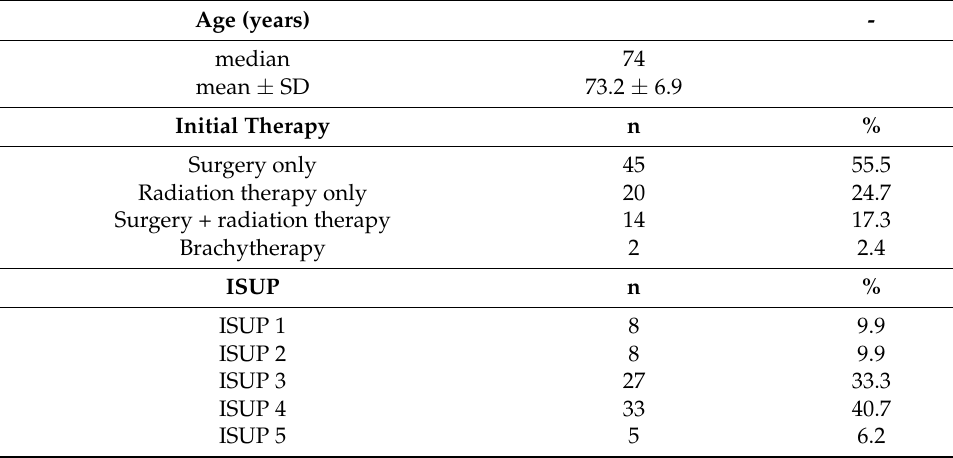
Figure 1. Diagnostic flow-chart for patient selection. Table 1. Summary of patients’ clinical-demographic